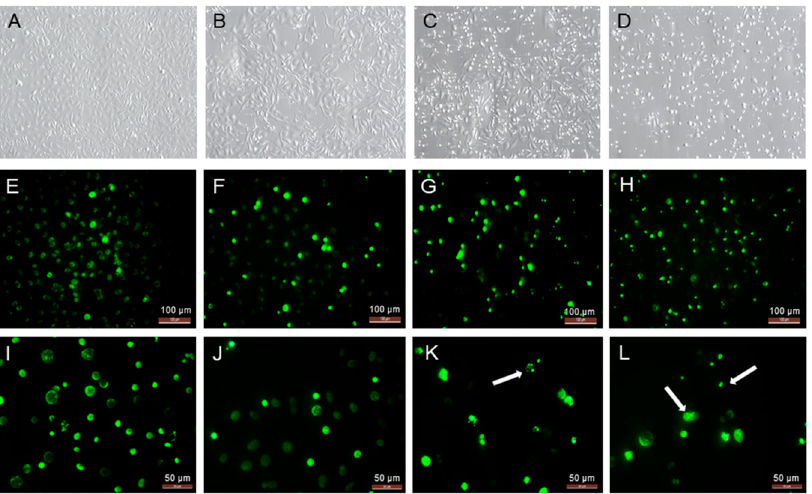
Figure 4. The SKOV-3 cells treated with yamogenin for 24 h and processed with Hoechst 33342 dye. The cells were incubated with ethanol (0.7% ( v/v )—a control, ( A , E , I )), yamogenin at concentrations of 20 ( B , F , J ), 50 ( C , G , K ), and 70 µg/mL ( D , H , L ), and then stained with fluorescent Hoechst 33342 dye ( E – L ). The cells were observed under 200× magnification ( A – H ) and 400× magnification ( I – L ). Arrows indicate the condensation of chromatin in the treated cells.